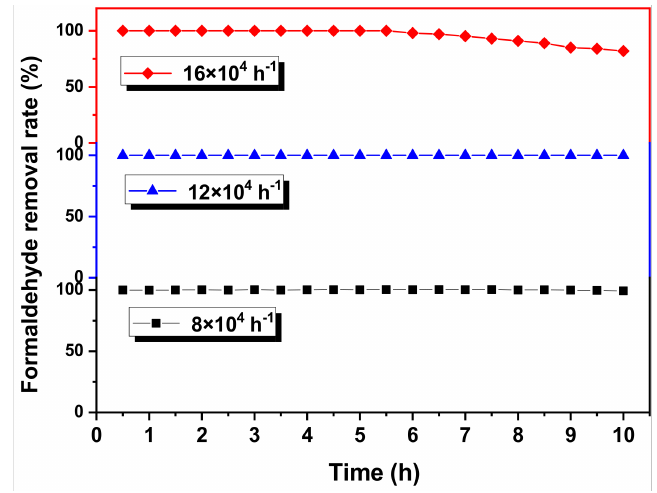
Figure 2. Degradation efficiency of 13-MnO 2 on HCHO at different space speeds; reaction conditions: reaction temperature = 25 ◦ C, initial concentration of HCHO = 4.02 mg/m 3 , RH =